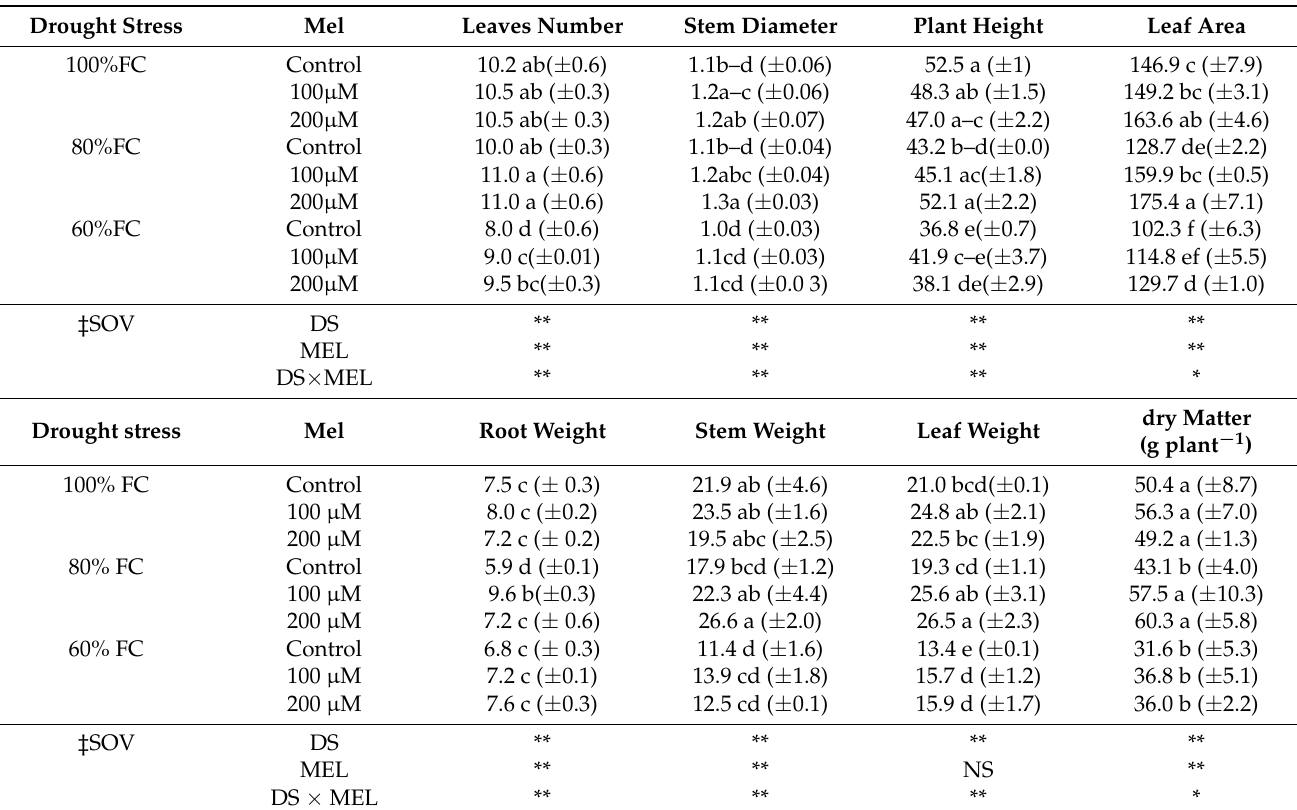
Table 2. Different growth traits of maize as affected by rooting application of MEL under drought stress. Values in parenthesis represent standard error of